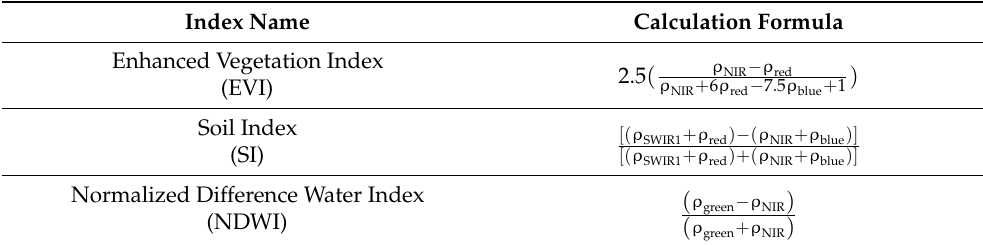
Table 3. Spectral Index Features used for Classification.